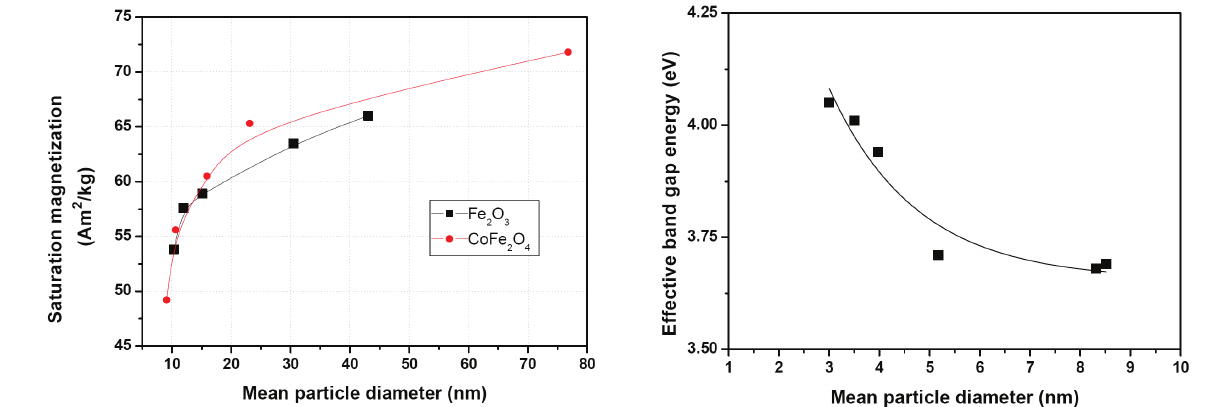
Figure 2. Examples for typical particle size-dependent physical properties. Left: Saturation magnetization as a function of particle size. Data taken from [15]. Right: Band as a function of particle size. Data taken from gap energy for SnO 2